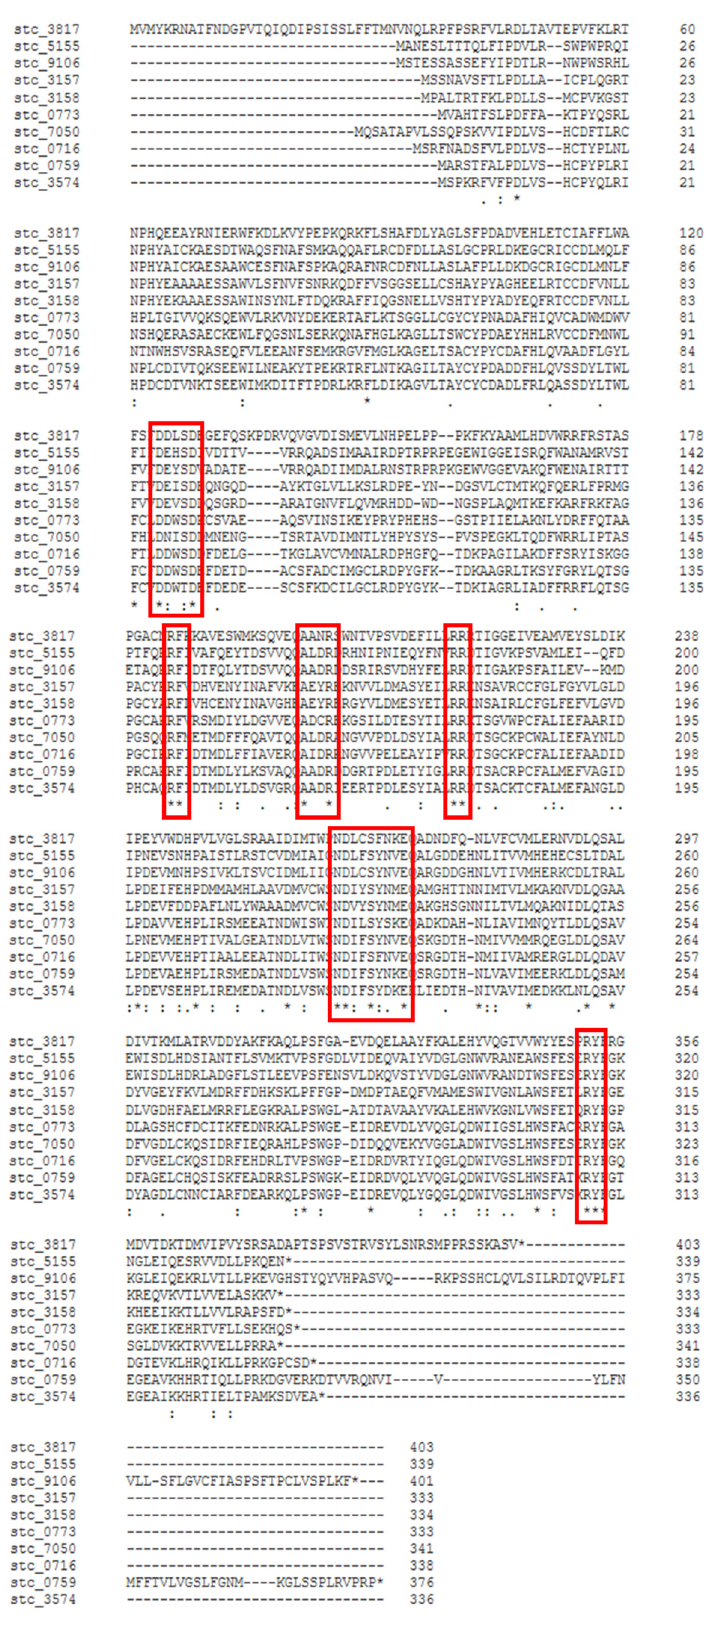
Figure 1. Sequence homology modeling of putative TPS of Cun. Conserved motifs are framed in red. Asterisks indicate conserved residues, colons equivalent residues and dots partial residue conservation.